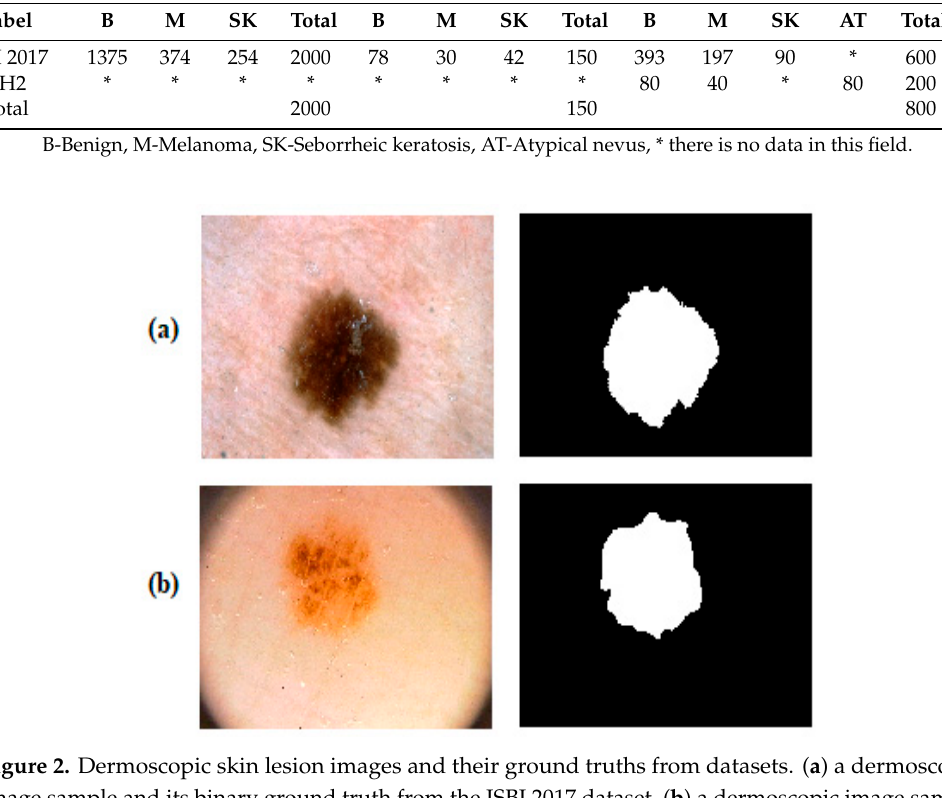
Table 1. Distribution of data and labels for training, validation, and test in the ISBI 2017 and the PH2 datasets. Dataset.